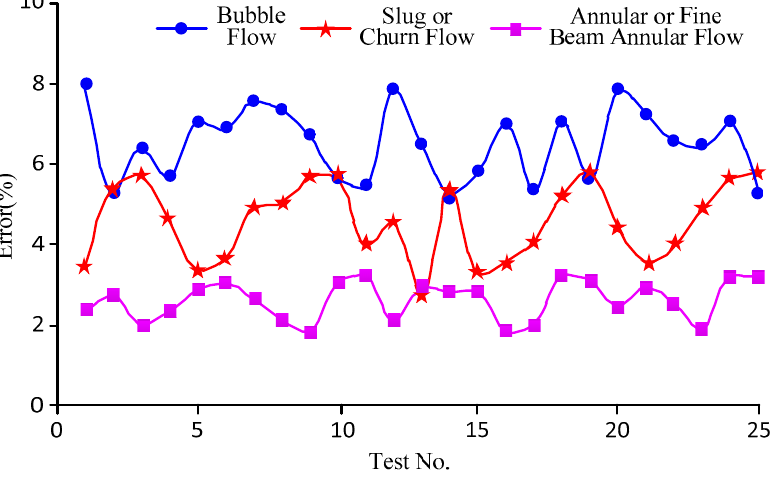
Figure 12. Error curves corresponding to different